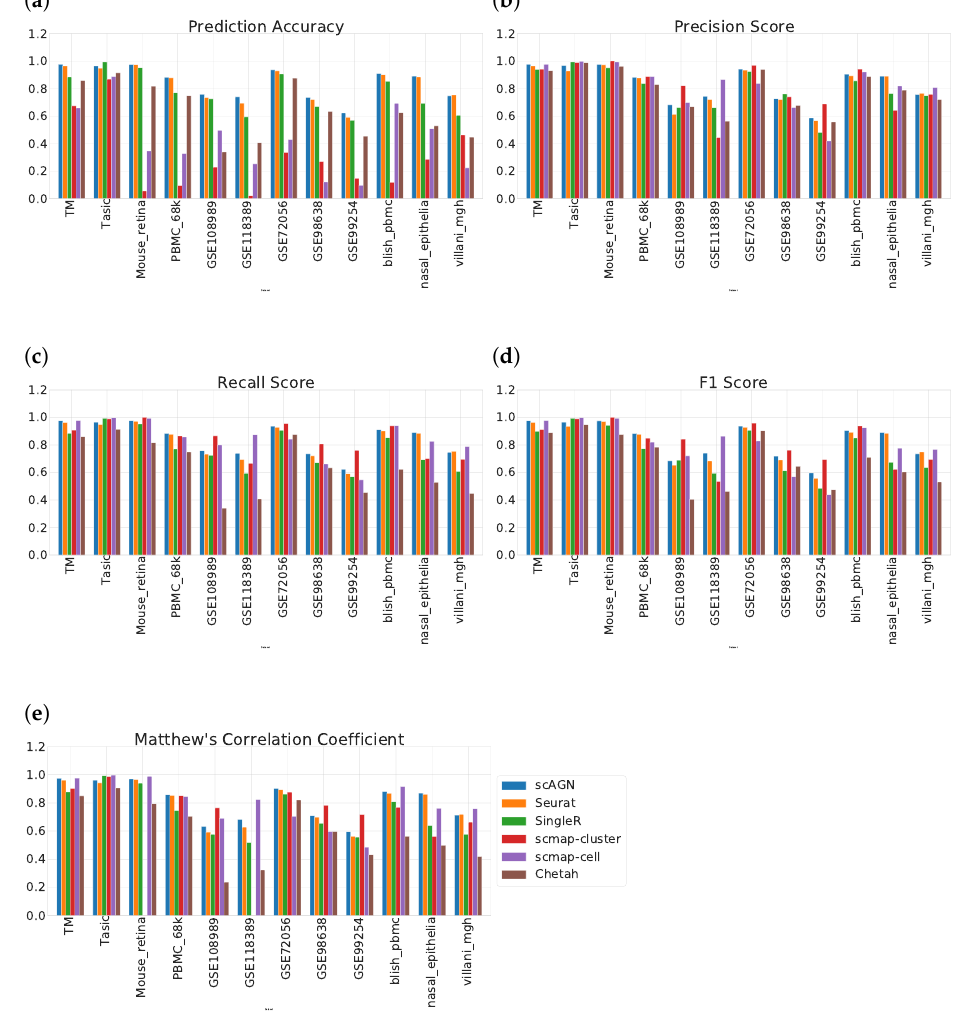
Figure 6. Performance evaluation of scAGN method against baseline methods using 12 real datasets. ( a ) We see that out of 12 datasets, scAGN performs best with 11 datasets. ( b ) In terms of precision score, there is no clear consensus on which method works best. However, the scAGN method performs 2nd best or 3rd best in all of the datasets. scMAP-cluster was best in 4 datasets out of 12 datasets. scMAP-cell was best in 5 datasets, while Seurat was best in only one dataset. Chetah and SingleR performed similarly. ( c ) Recall score for all six methods on 12 datasets. From the recall score also, we can see that there is no clear consensus on which method is the best. ( d ) F1 score also shows a similar trend as the recall score and our method is best in two datasets and second best or third best in the rest of the datasets. ( e ) From the MCC value, we see that scAGN is best in three datasets, while scmap-cell is best in four